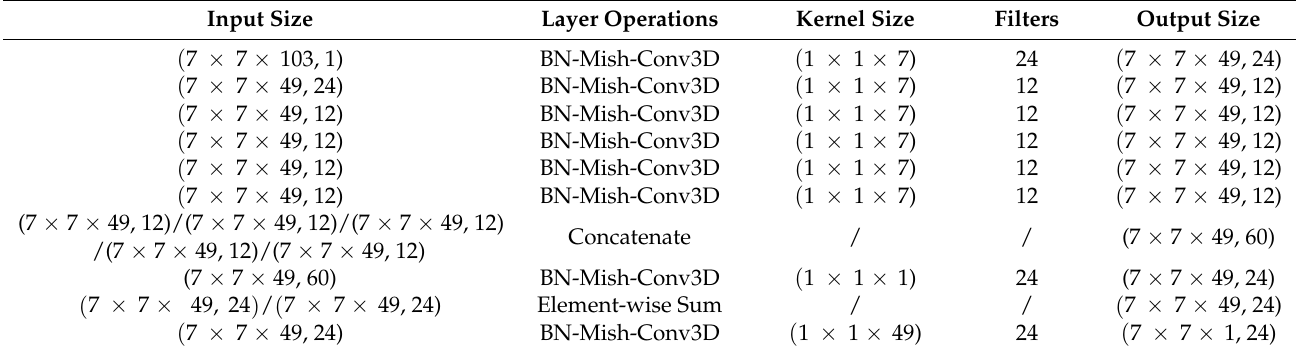
Table 1. Detailed steps of the spectral one-shot dense block.